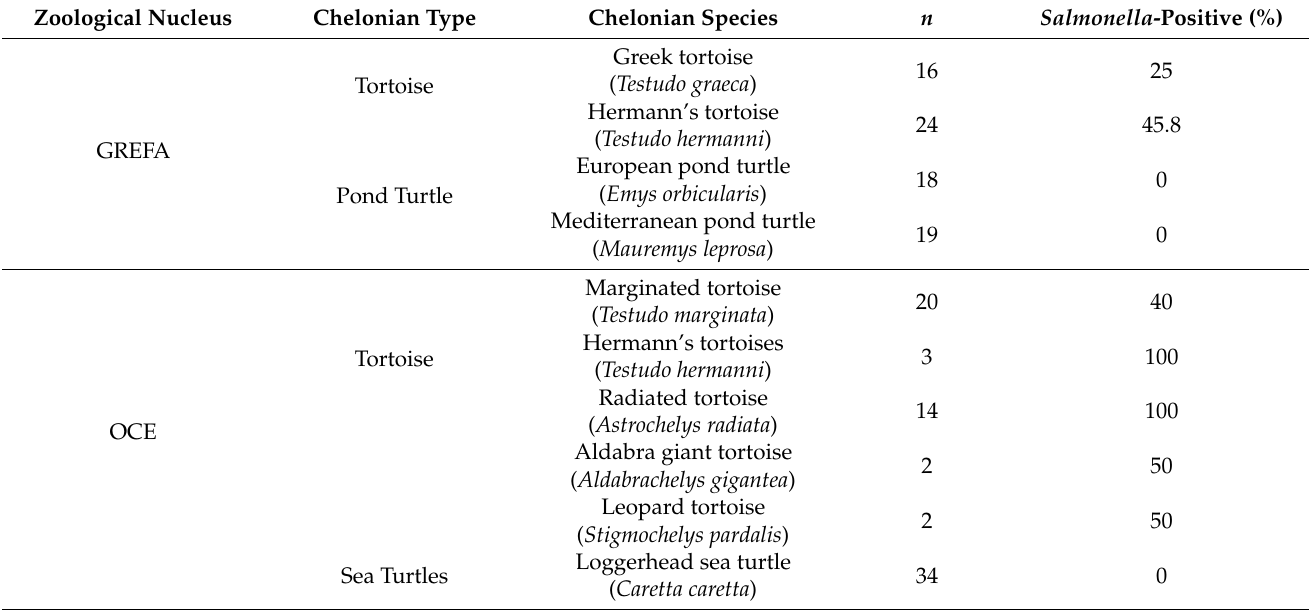
Table 2. Details of Salmonella detection among the different chelonian